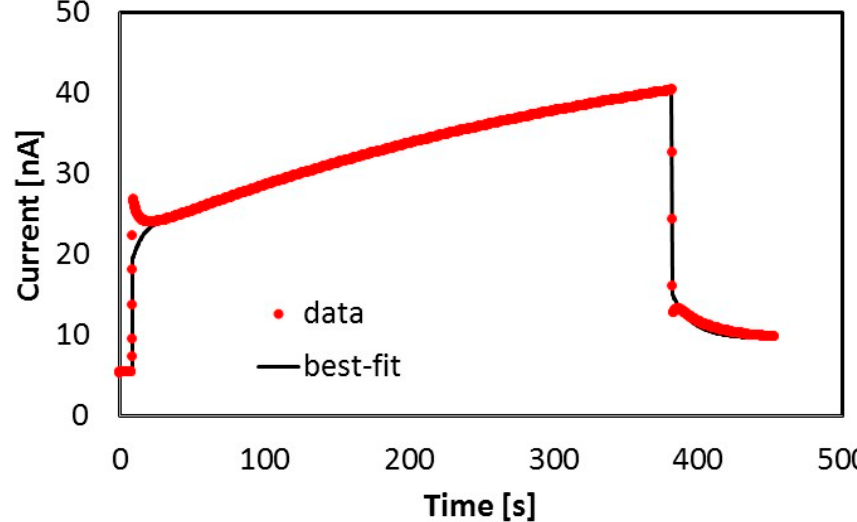
Figure 6. Photoconductivity measured at T = 291.6 K, V b = 5 V with a 400 nm LED source, during the priming used for thermally stimulated current analysis shown in Figure 2.